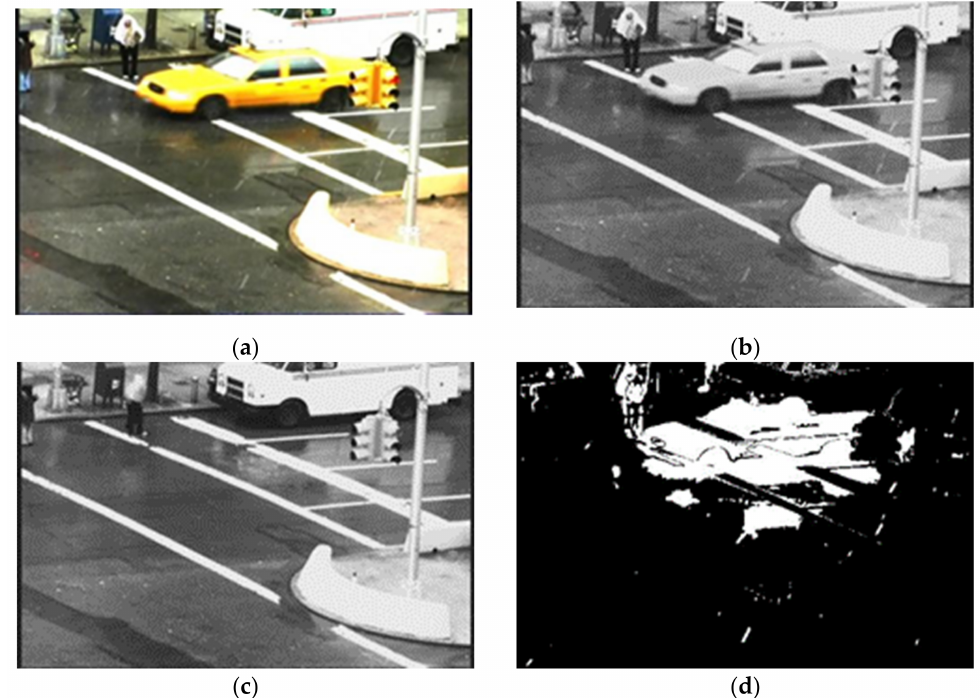
Figure 3. Results of background modelling of the “Traffic” video sequence to demonstrate the separation of moving regions, including rain streaks from the background ( a ) input frame 79 ( b ) Y component of input ( c ) background of the frame 79 and ( d ) binary foreground of the frame